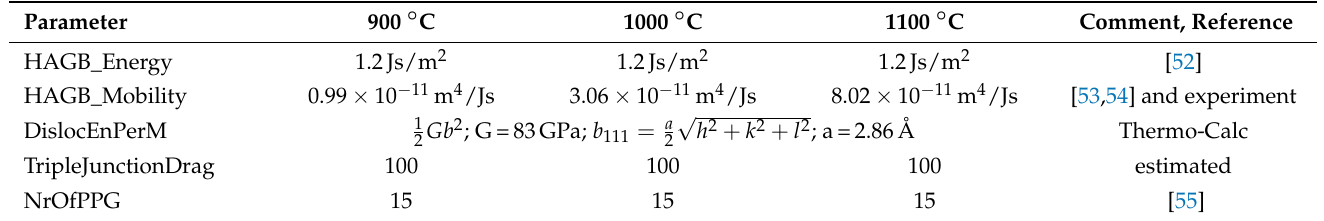
Table 5. Input parameters and their origin for the GraGLeS2D+ level-set model for the annealing temperatures 900°C, 1000°C, and